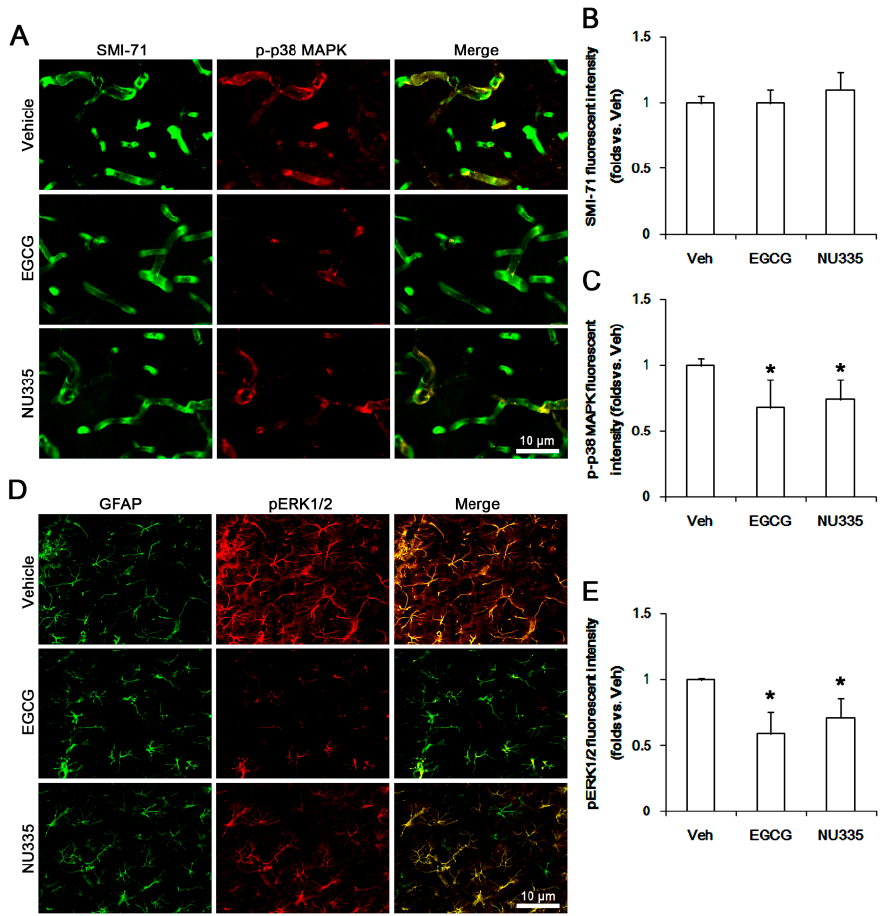
Figure 5. Effects of EGCG and NU335 on endothelial p-p38 MAPK and astroglial pERK level in the PC under physiological condition. EGCG and NU335 abolish p38 MAPK and pERK levels in endothelial cells and astrocytes, respectively. ( A ) Representative images for endothelial p-p38MAPK signals in the PC. ( B , C ) Quantification of the effect of EGCG and NU335 on SMI-71 (an endothelial blood–brain barrier (BBB) antigen) and p-p38MAPK fluorescent intensities ( n = 7, respectively). Error bars indicate S.E.M. Significant differences are * p < 0.05 vs. vehicle-treated animals. ( D ) Representative images for astroglial pERK signals in the PC. ( E ) Quantification of the effect of EGCG and NU335 on pERK1/2 fluorescent intensity ( n = 7, respectively). Error bars indicate S.E.M. Significant differences are * p < 0.05 vs. vehicle-treated animals.